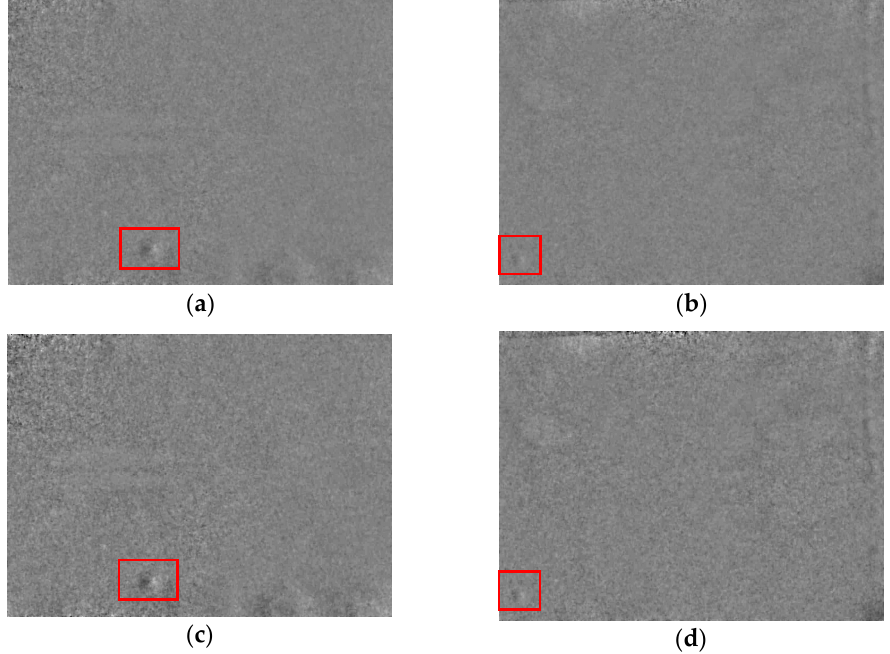
Figure 3. Image enhancement ( a , b ) original speckle images, ( c , d ) Contrast enhanced images.